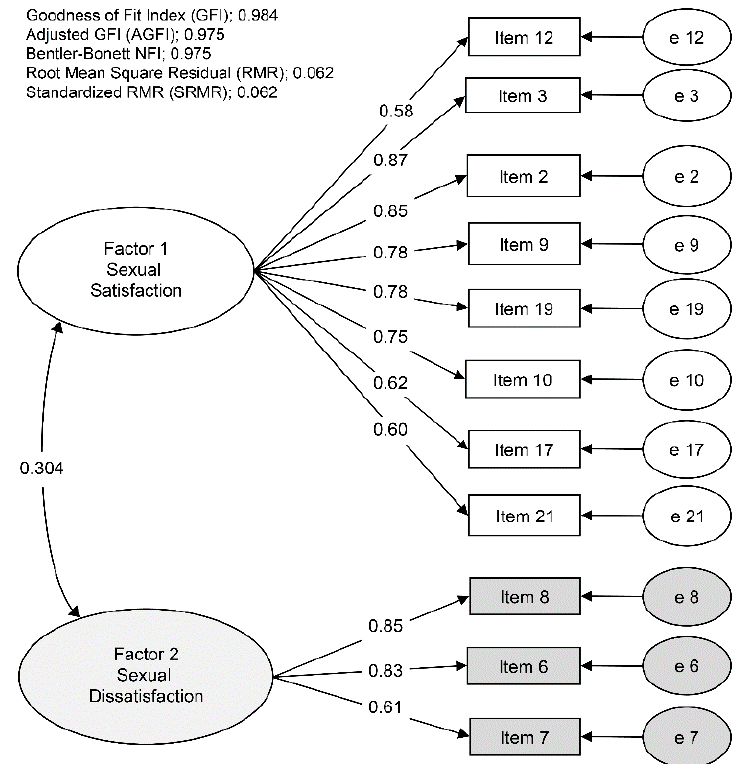
Figure 1. Confirmatory factor analysis of the revised Japanese version of the Index of Sexual Satisfaction. Data drawn from the even-numbered group ( N = 294). Numbers superimposed on lines show the standardized loading of each item and the standardized covariance between factors 1 and 2; all p < 0.001.